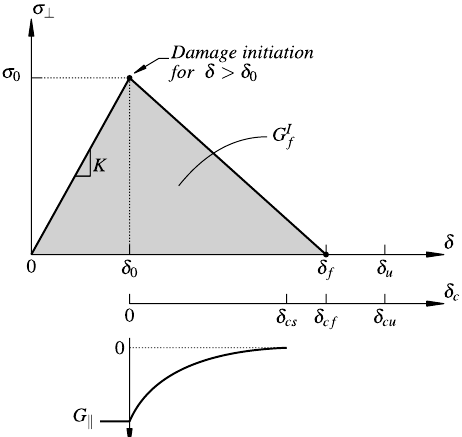
Fig. 3: Representation of the Hillerborg model describing the tensile stress perpendicular to a crack (mode I fracture) as function of relative nodal displacement ( δ ) and crack opening displacement ( δ c ), as well as the shear stiffness reduction as function of crack opening displacement (adapted from Pelfrene et al.